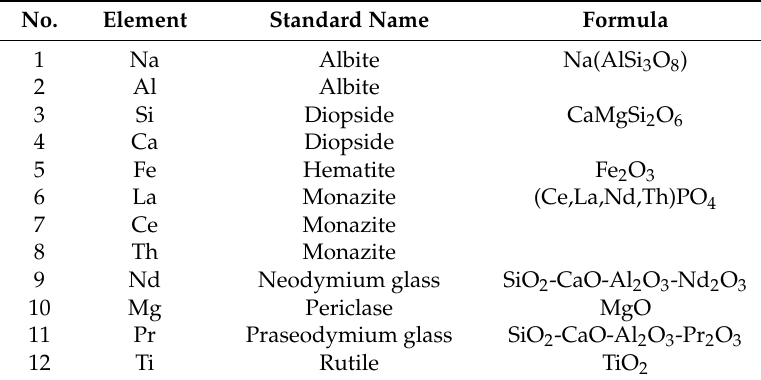
Table 1. Standards used for wavelength dispersive spectroscopy (WDS)